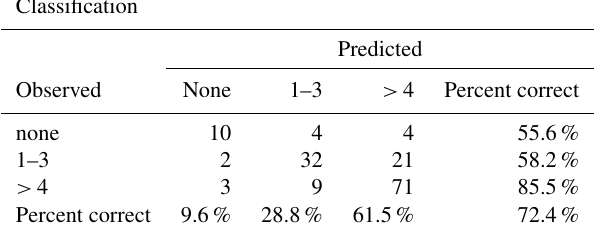
Table 2. Confusion